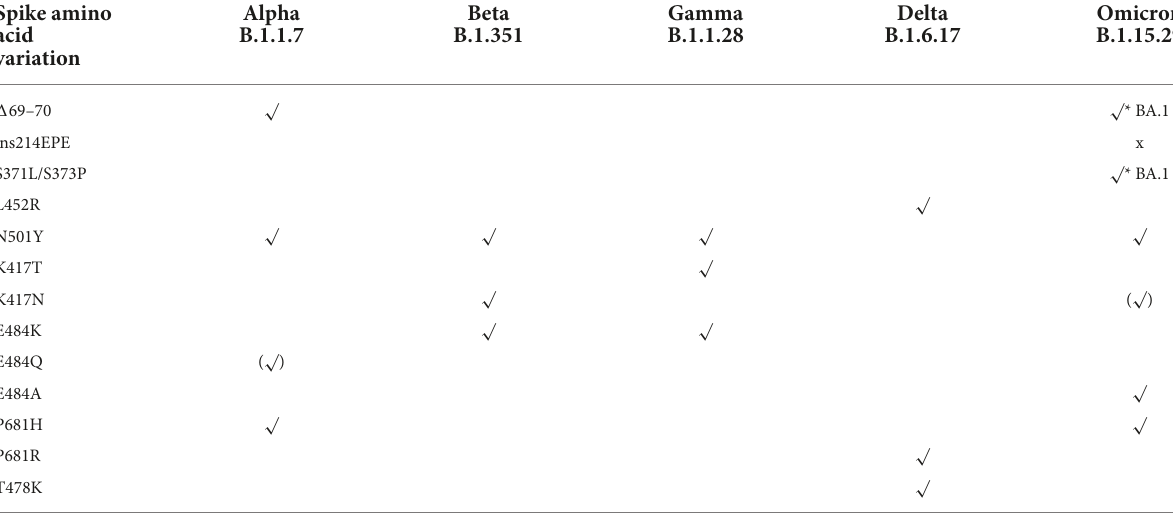
TABLE 2 The combination of mutations that can be used as a proxy marker to identity SARS-CoV-2 variants (33). Spike amino